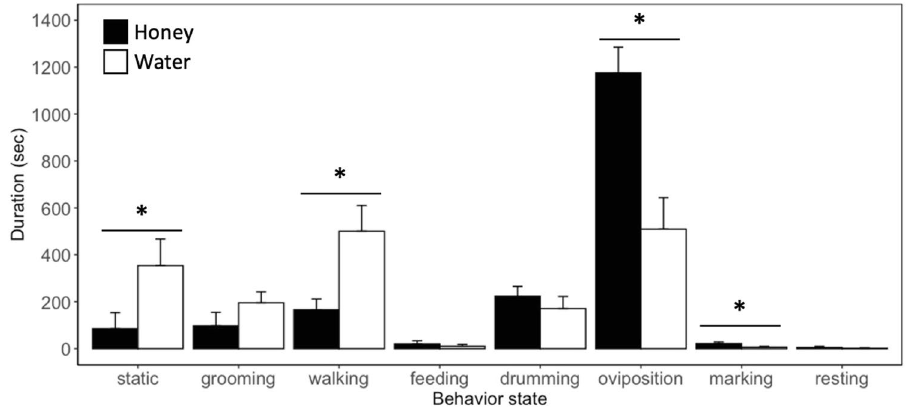
Figure 2. Duration (mean + SE) spent within each behavior state in 30 min period by H. pennsylvanicus female when provided L. zonatus host eggs and fed a honey-water (honey) or water diet (water). Statistical significance between treatments indicated by asterisk ( P < 0.05; GLM and likelihood ratio chi-squared test).